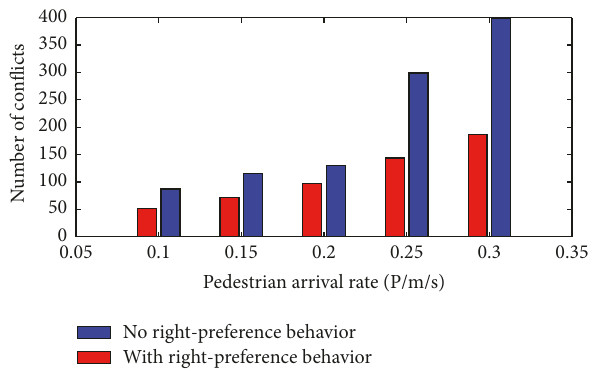
Figure 16: The number of conflicts for different pedestrian arrival rates in 240s. In this article, the definition of the conflict is that the distance between two pedestrians with opposite moving directions 𝑑 ⩽ 5 cm and their relative position |𝑙 𝑖𝑗